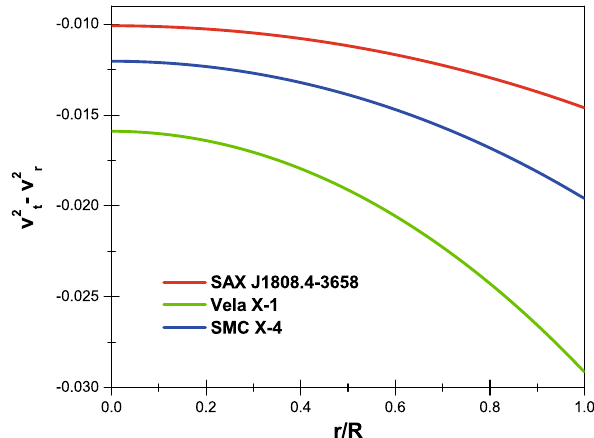
Fig. 21 Behaviour of v 2 t − v 2 r against the fractional radius for α = 0 . 3